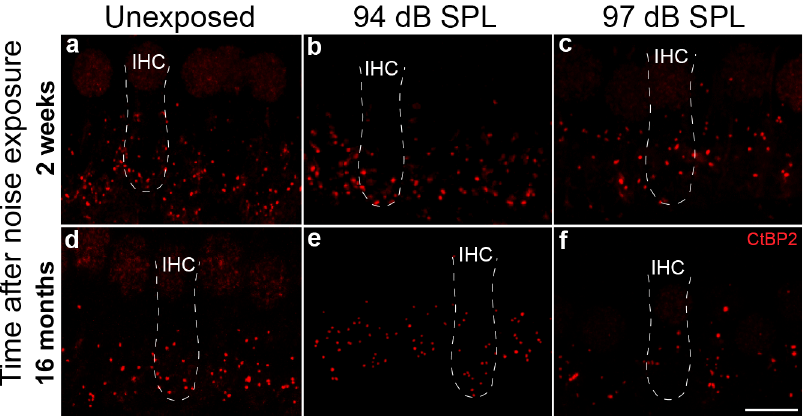
Fig 3. Confocal imaging shows a reduction in CtBP2 stained presynaptic ribbons following neuropathic noise. Short-term ( a - c ) and long-term ( d - f ) loss of presynaptic ribbons in inner hair cells (IHCs) after exposure to neuropathic (97 dB SPL) noise compared to age-matched animals exposed to non- neuropathic noise (94 dB SPL) and unexposed controls. Presynaptic ribbons are labeled with anti-CtBP2 antibodies (red). Confocal images are maximal projections of z-stacks of ribbons within 4 – 5 IHCs in the 32 kHz region. Dashed lines depict IHC outlines. Scale bar: 10 μ m ( a - f ).